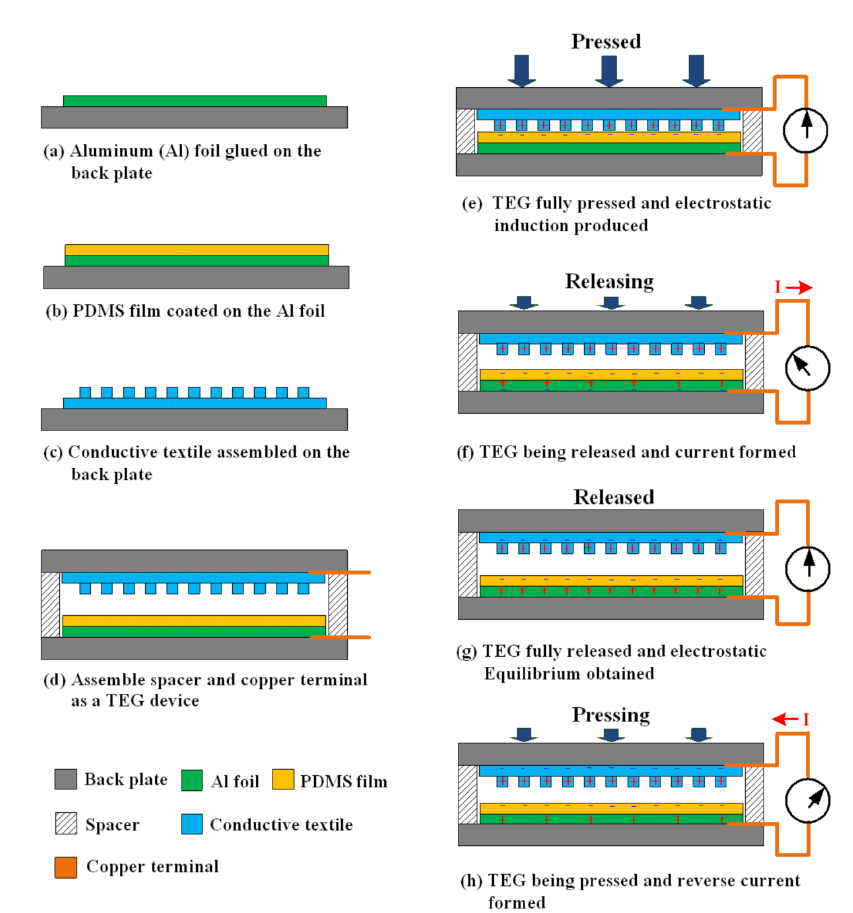
Figure 1. Schematic illustration of proposed triboelectric generator (TEG) structure, fabrication process, and power generation